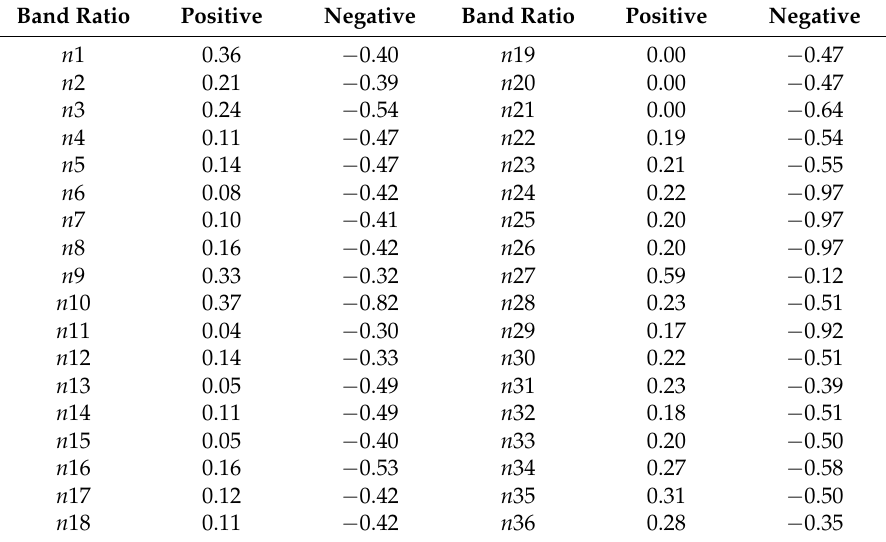
Table 3. Positive and negative correlation of the band ratios n 1– n 36 in the construction of resultant principal components for a selected subset of the study